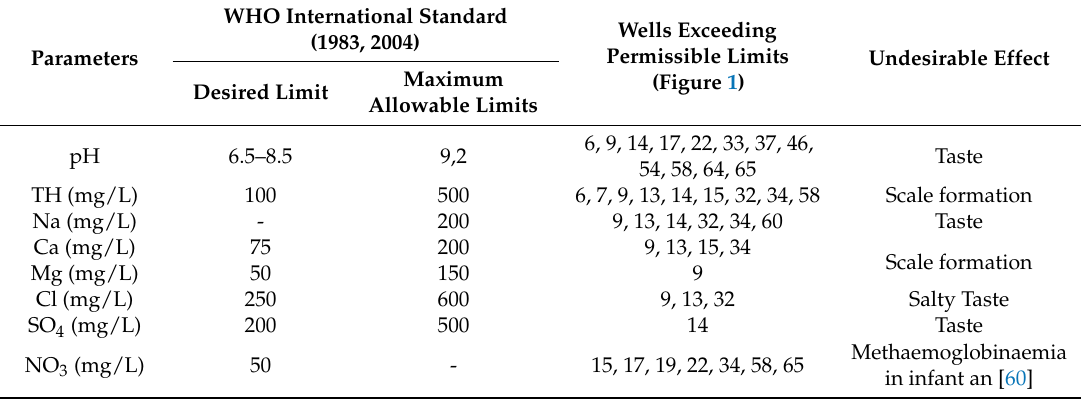
Table 4. Groundwater samples of the study area exceeding the permissible limits prescribed by WHO for drinking purposes.